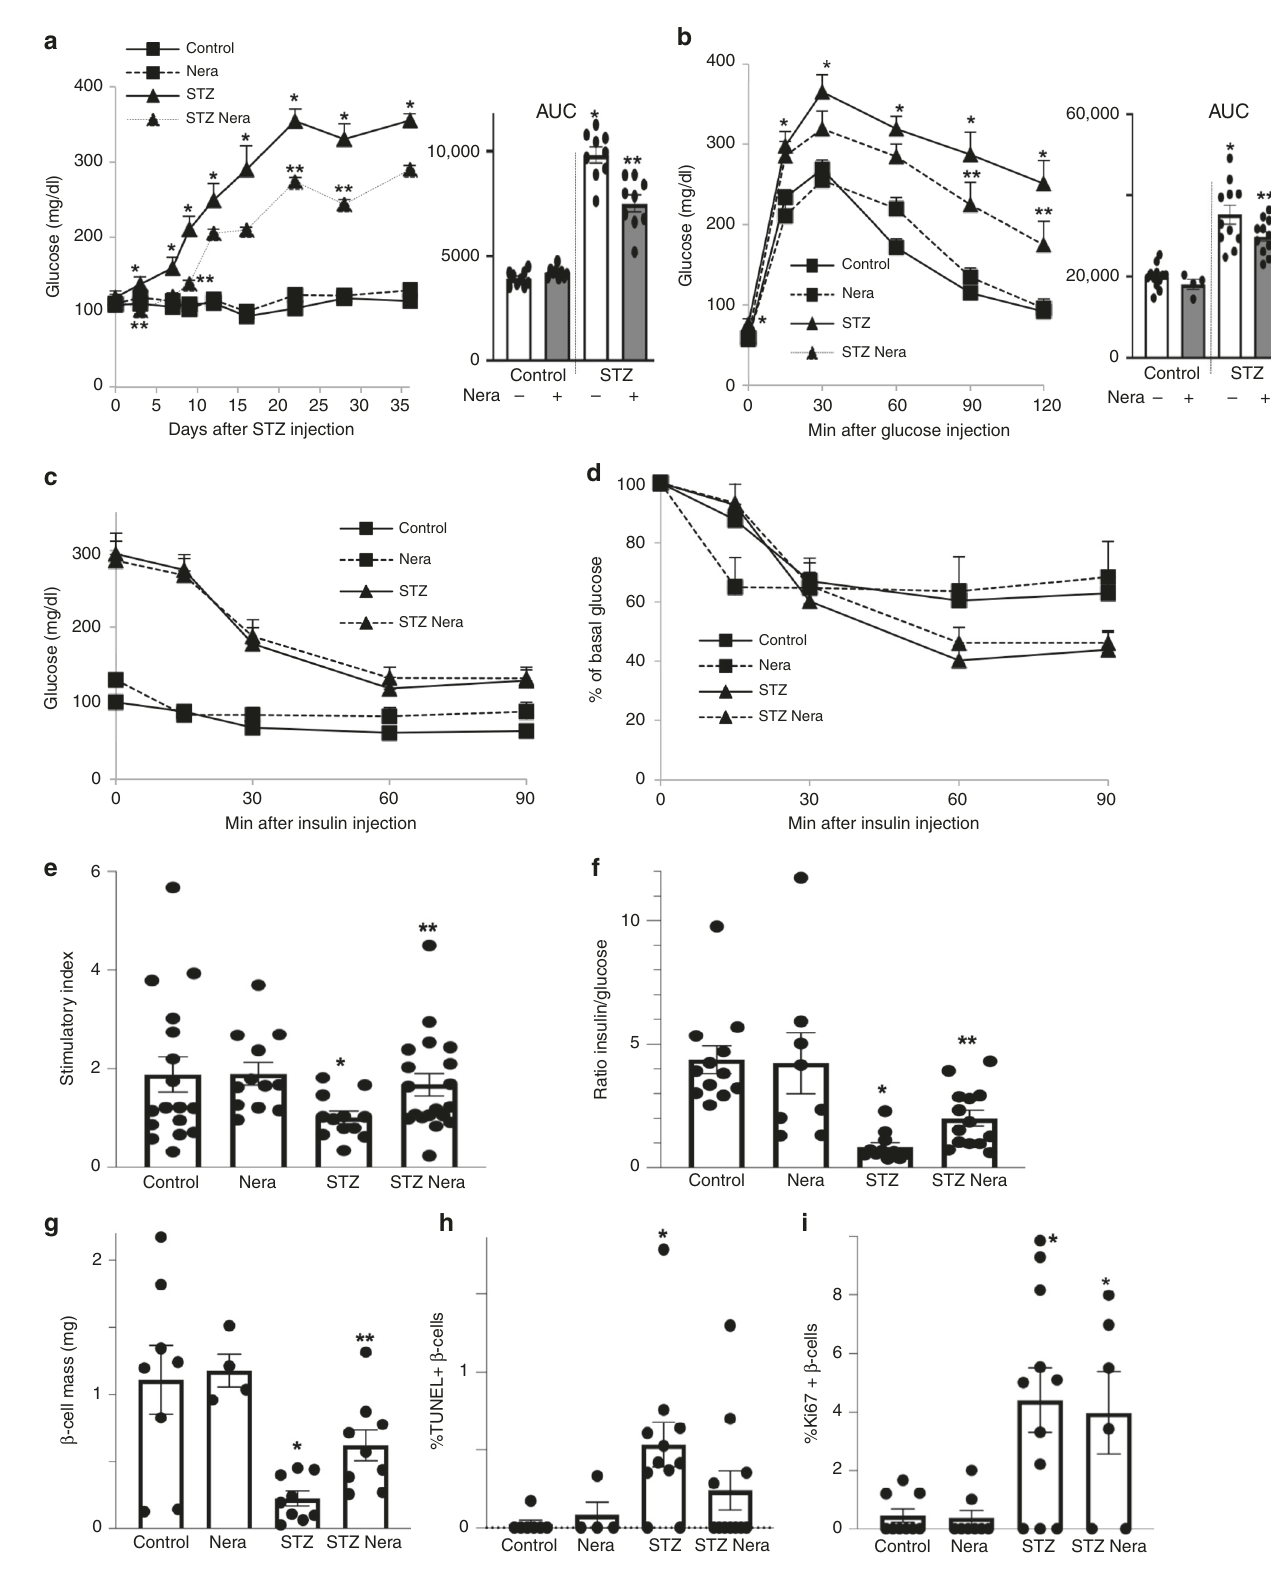
Neratinib restores glycemia in a T2D mouse model . Obese diabetic Lepr db/db mice (db/db, Fig. 8) become severely